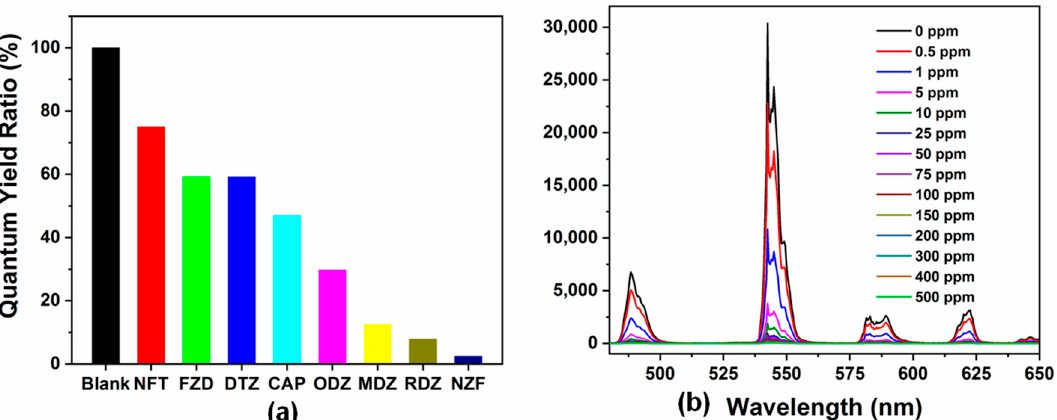
Figure 3. ( a ) The quenching efficiency of ZTU-5 by the 50 ppm concentrations of antibiotics in the DMF solution; ( b ) emission spectra of ZTU-5 in the DMF solution with the different concentrations of nitrofurazone (NZF). NFT, nitrofurantoin; FZD, furazolidone; DTZ, dimetridazole; CAP, chloramphenicol; ODZ, ornidazole; MDZ, metronidazole; RDZ, ronidazole.